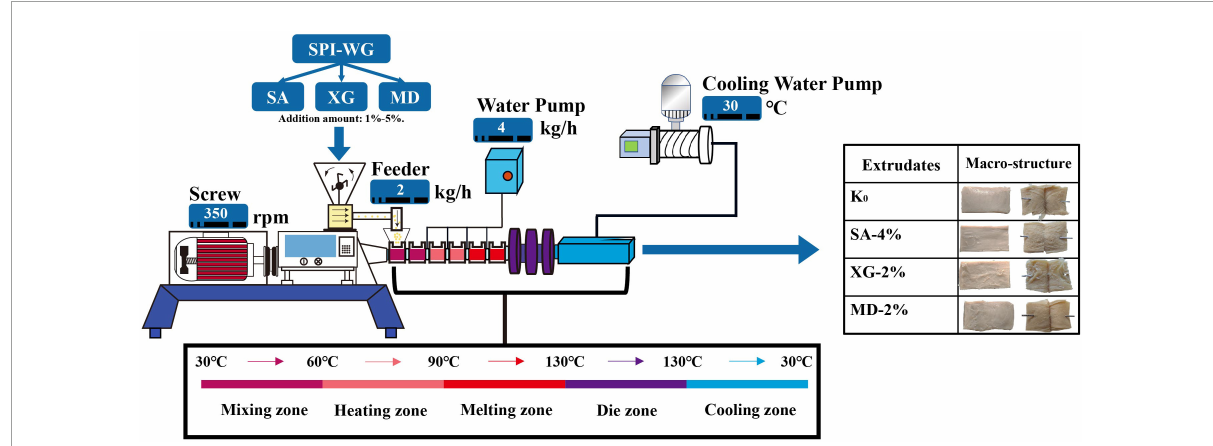
FIGURE1 Schematic diagram of high-moisture extrusion cooking process of soybean-wheat protein with different amounts of sodium alginate (SA), xanthan gum (XG), and maltodextrin (MD) (including the division of sampling section and macro-structure of